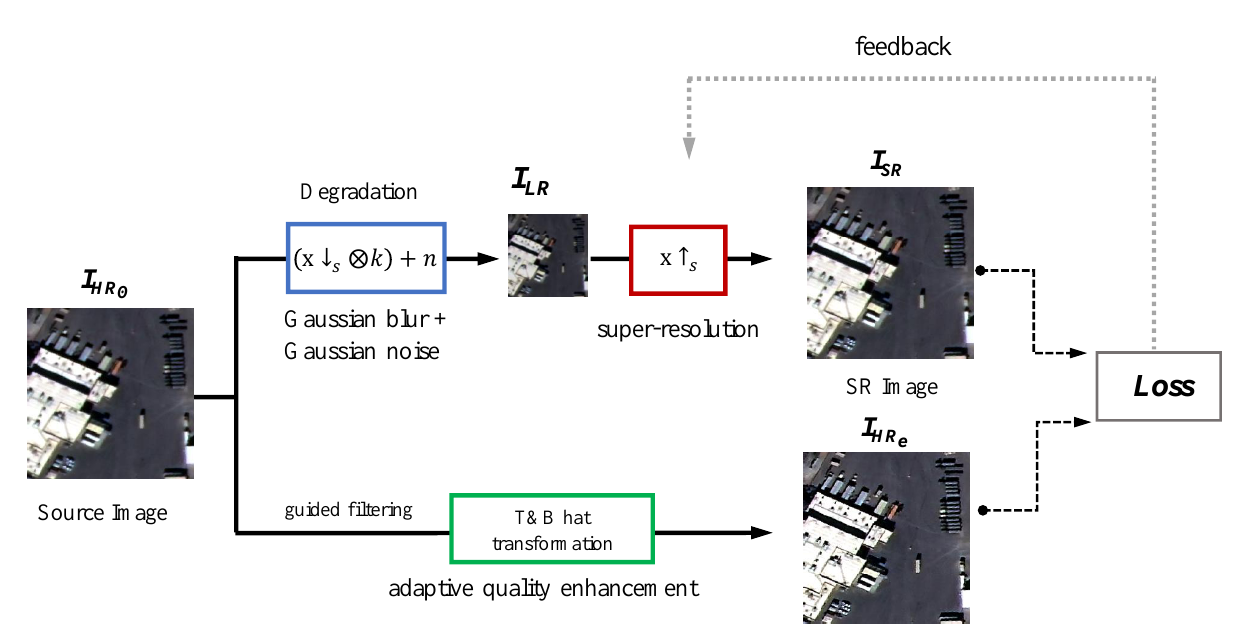
Figure 1. Architecture of the proposed SR method for training